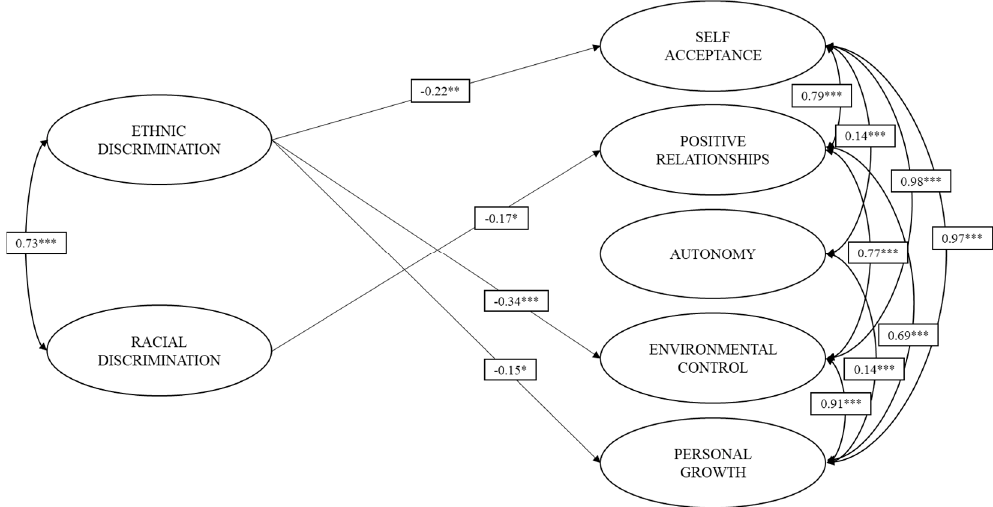
Figure 1. Relationship between ethnic and racial discrimination and the domains of psychological well-being. Only the statistically significant effects of the model are plotted. * p < 0.05. ** p < 0.01. *** p < 0.001.